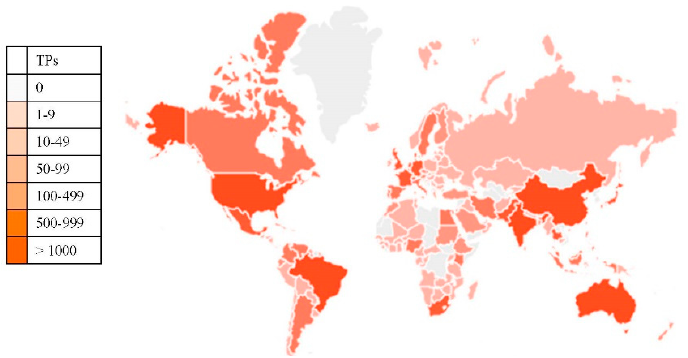
Figure 2. Global distribution of publications related to sugarcane research. TPs: Total